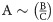
An example of two potential metabolic forks detected from the data through linear models.Each one represents a triplet whose models A∼(BC) and (BC)∼A have significant interaction terms between control and heat stress conditions.